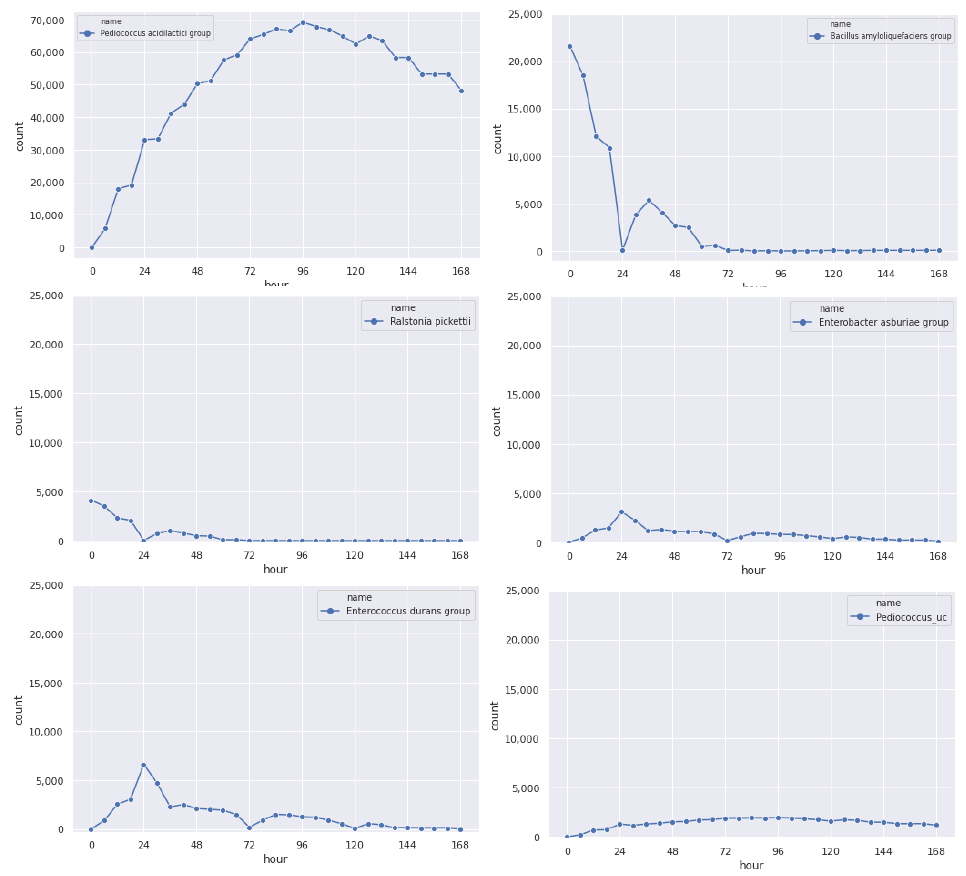
Figure 9. Results of the imputation, generating count for each microbial community every 6 h